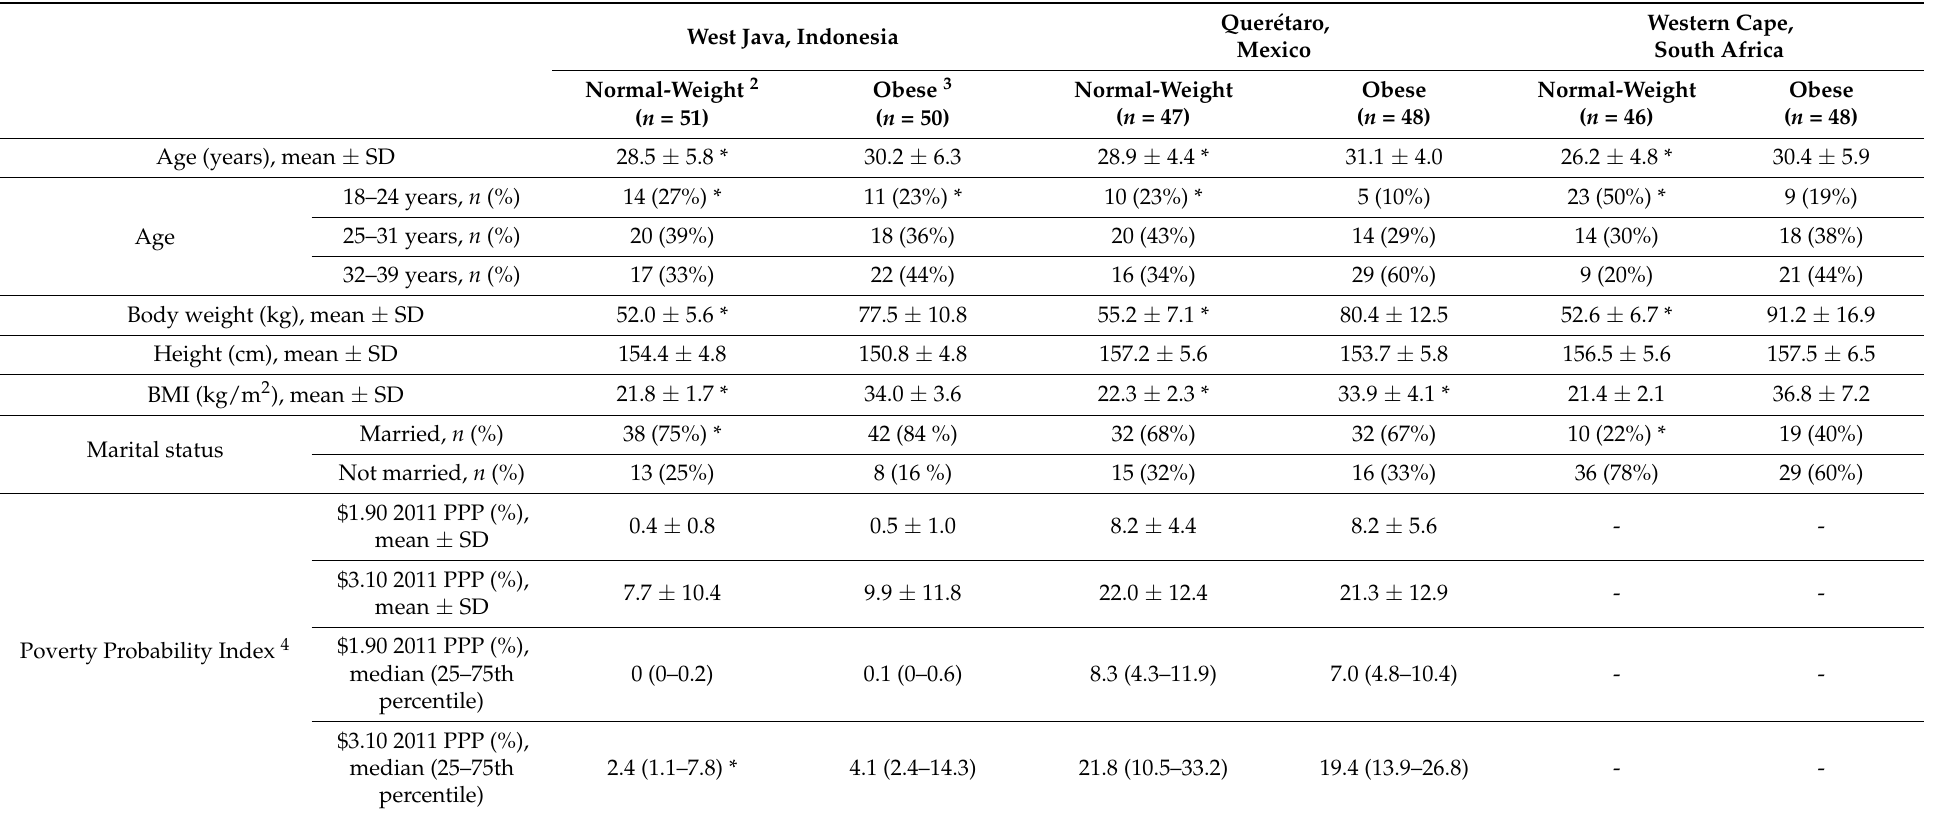
Table 1. Characteristics of the participants by survey area for normal-weight vs. obese women 1 . West Java, Indonesia